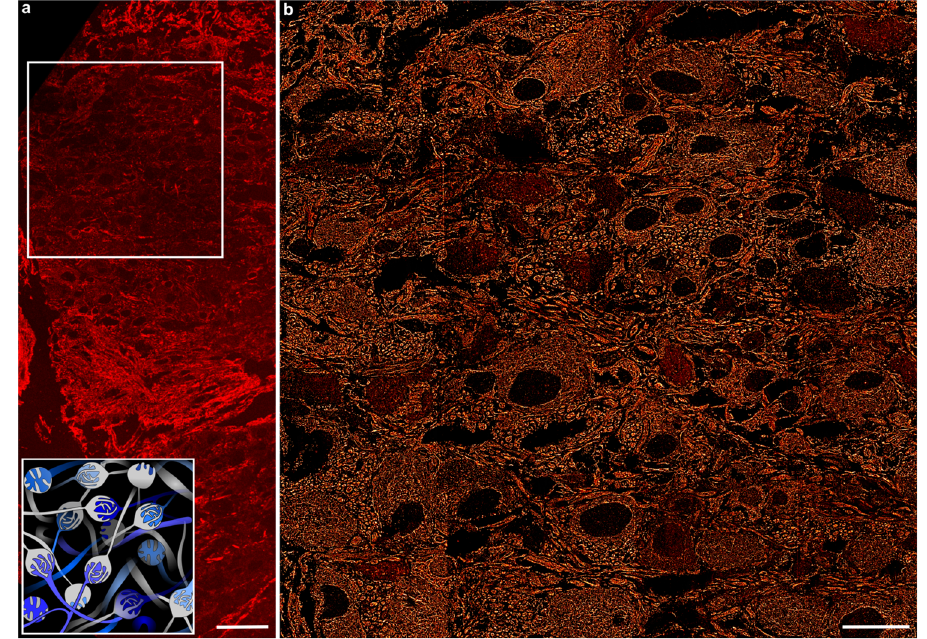
Fig. 5 | Accelerated large-sample imaging with DeepSTORM DNA-PAINT. a Confocal microscopy image of an MNTB tissue section and a graphical repre- sentation of calyces organised within the MNTB region (inset; blue indicates prin- cipal cells and in grey are the postsynaptic Calyx of Held). b Large-area super- resolution image recorded for the tissue area de fi ned by the bounding box in ( a ).